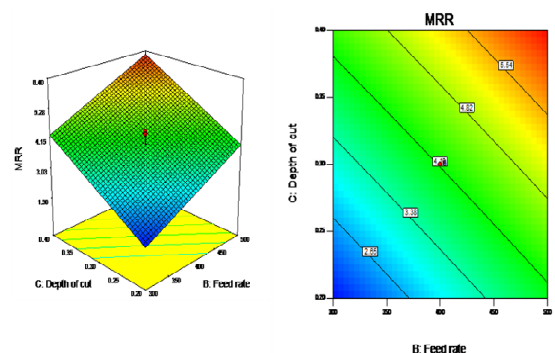
Fig. 11: 3D Response and Contour plot of Material Removal Rate Vs Feed Rate and Depth of